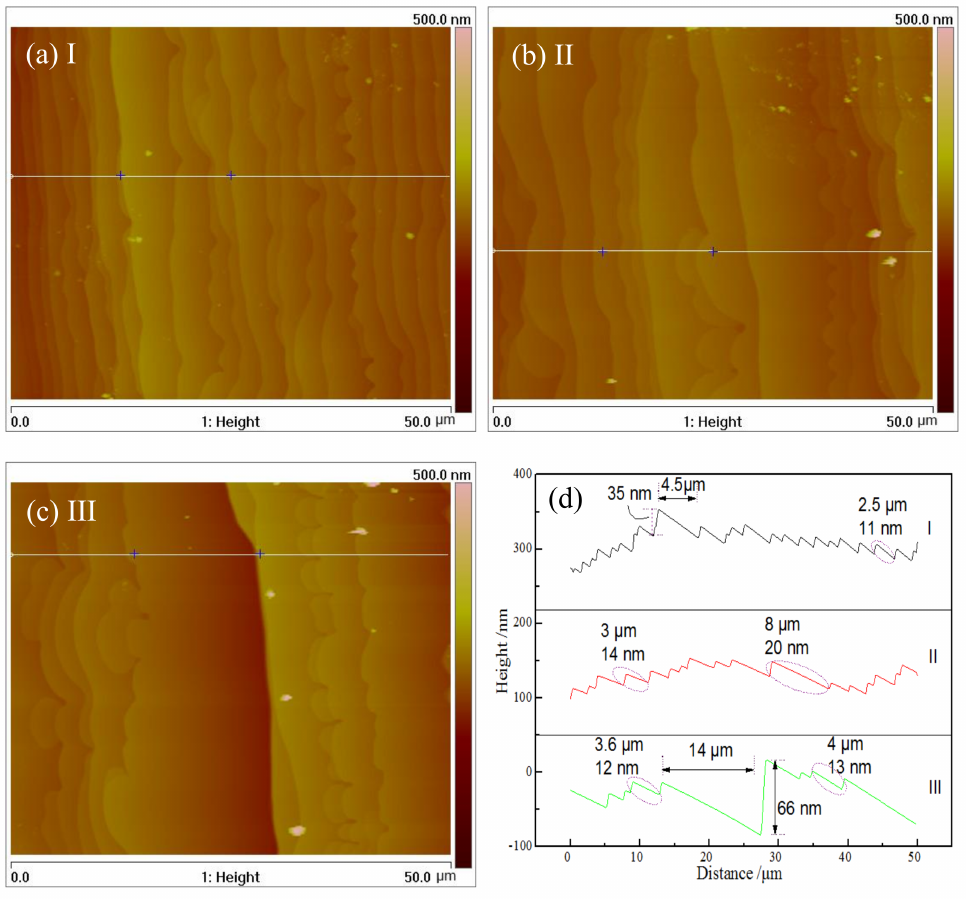
Figure 4. Atomic force microscope (AFM) analysis of surface of Wafer C2: ( a ) region I; ( b ) region II; ( c ) region III marked in Figure 3c; ( d ) section analysis for corresponding regions in ( a – c